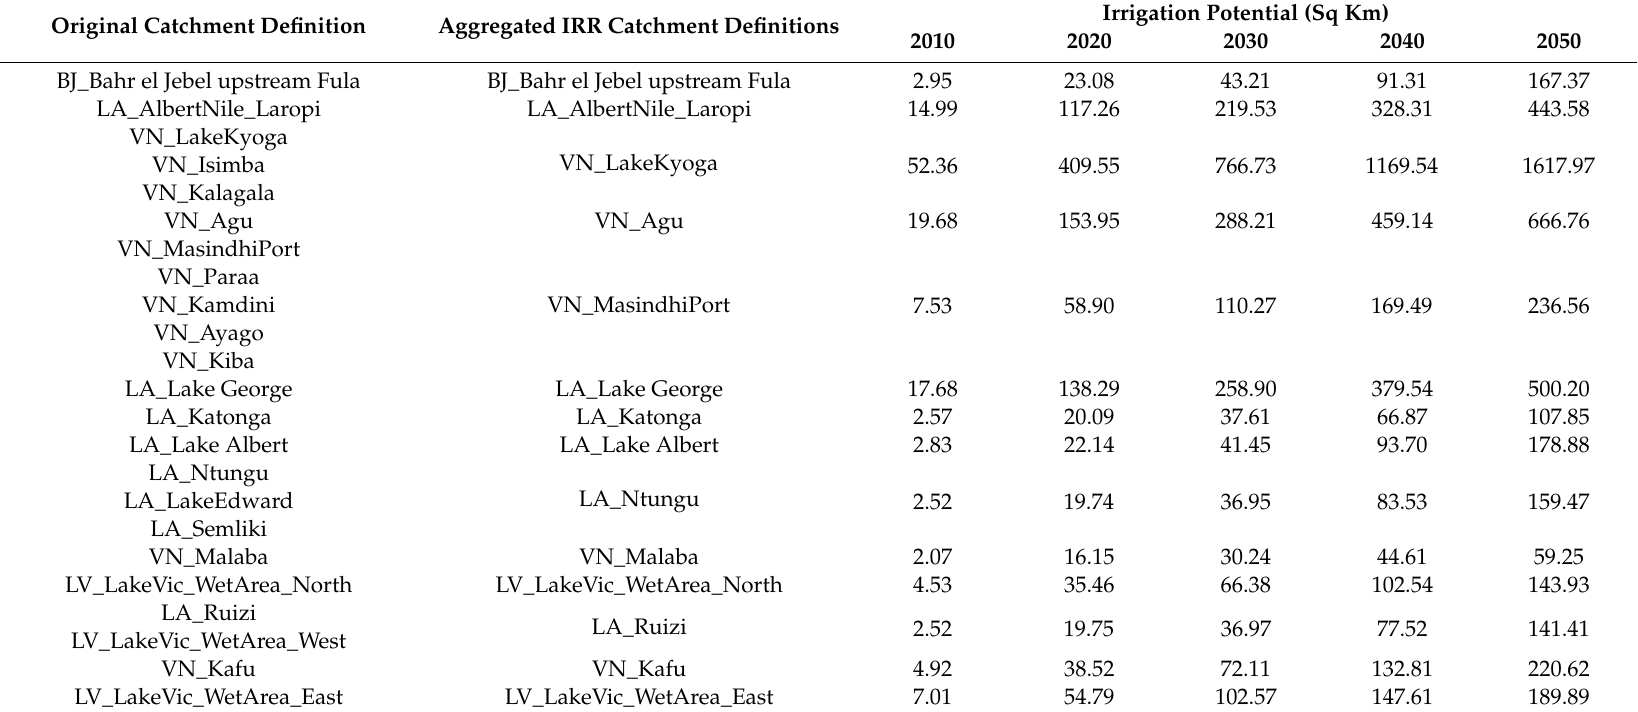
Table A2. Irrigation